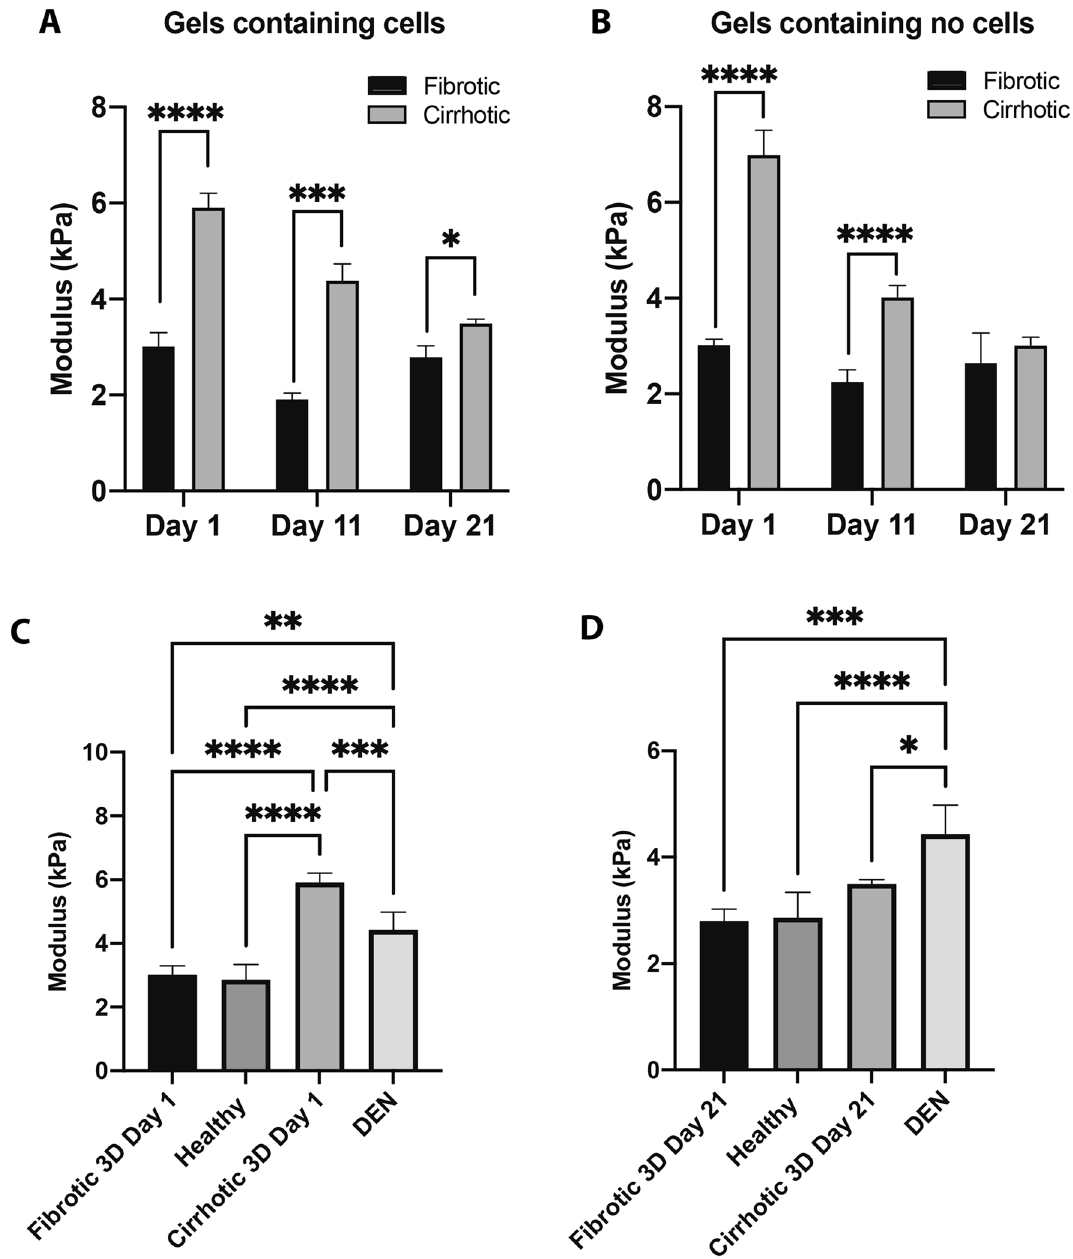
Figure 1. Liver stiffness determined via parallel plate rheology in different 3D hydrogels and liver samples derived from a DEN-induced model for HCC). ( A ) Storage modulus of 3D hydrogels resembling a cirrhotic and fibrotic liver, grown with cells on day 1, 11 and 21. ( B ) Storage modulus of 3D hydrogels resembling a cirrhotic and fibrotic liver, seeded without cells, measured on day 1, 11 and 21. ( C ) Storage modulus of 3D hydrogels compared to the liver biopsies derived from a DEN-induced mouse model for HCC at day 1 and ( D ) day 21 of culture (n = 3, error bars = SD, ****p < 0.0001; ***p < 0.001, **p < 0.01, *p < 0.05). Gel conditions (mouse